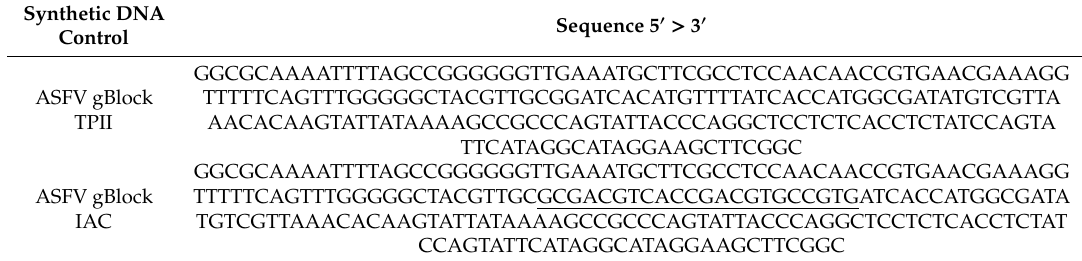
Table 2. Sequences of the African swine fever virus (ASFV) synthetic gBlock TPII and internal amplification control (IAC). The underlined section in the IAC gBlock is the altered region resulting in an elevation of the T a